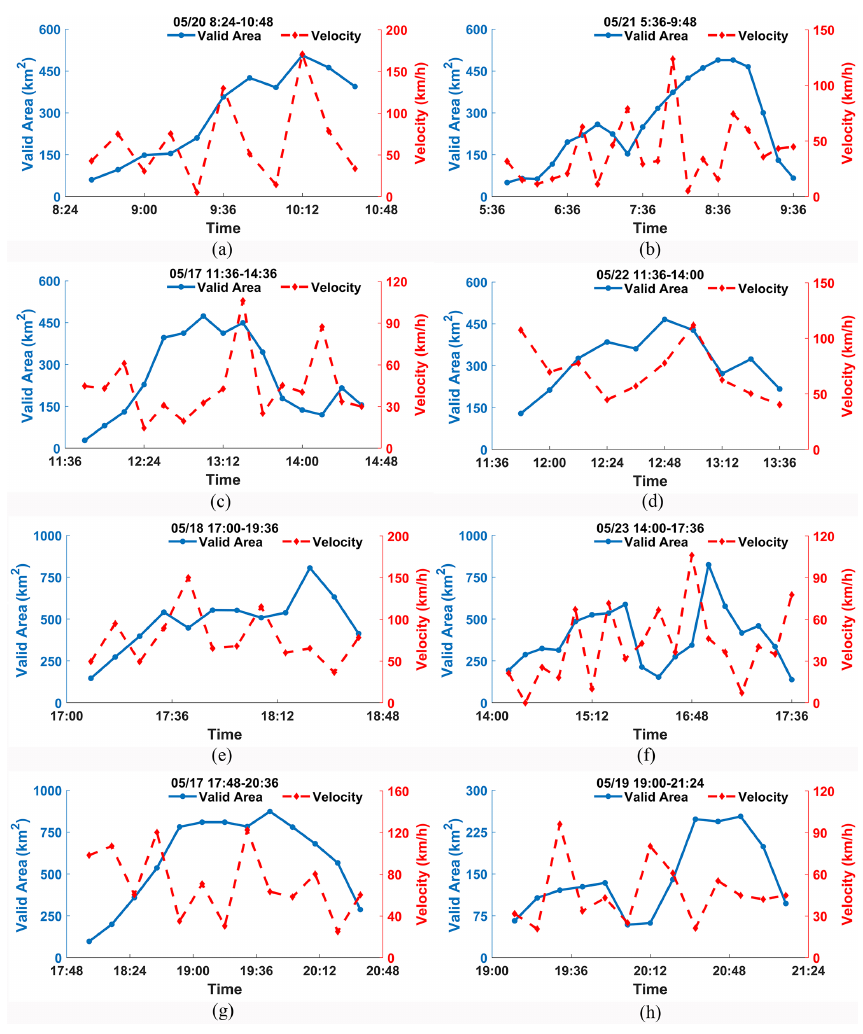
Figure 6. Valid area and velocity of eight cases, as a function of time. The solid blue line and the dotted red line represent the valid area and velocity within a time interval, respectively.